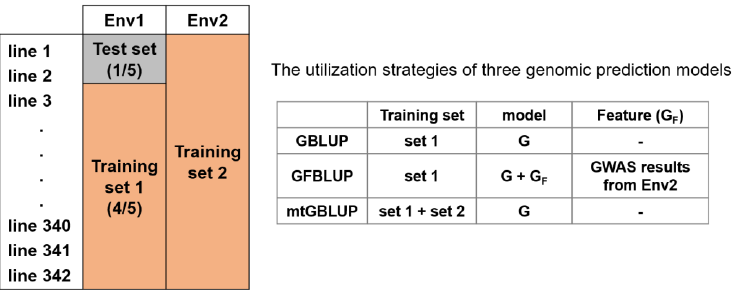
Figure 1. A scheme of cross validation using multiple environment phenotypes for genomic prediction. mtGBLUP model directly utilizes the Env2 phenotypes, while GFBLUP model only leverages the Env2 information (GWAS summary statistics). Env1/Env2 = Dry season or Wet season, GWAS = Genome-wide association study. G = Genomic relationship matrix using all markers, GF = Genomic feature relationship matrix using specific selected